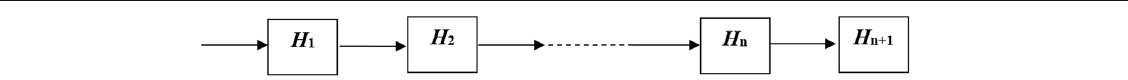
Fig. 4 Estimation of the connection length from H1 to Hn+1. The timestamp gap between a send packet and its matched echo packet collected at H1 (the sensor) can be used to indicate the length of the connection chain from H1 to Hn+1. The timestamp gap between a send packet and its matched echo packet collected at H 1 (the sensor) is denoted as RT T e = te − ts . It is apparently not correct to use the timestamp gap between a send and its matched echo to represent the length of the connection from H 1 to H 2 . What Yung ’ s approach used is the timestamp gap between a send packet and its ACK packet collected at H 1 . We denote this gap as RT T a = t a - t s . The ratio RT T a / RT T e can approximately tell how long the connection from